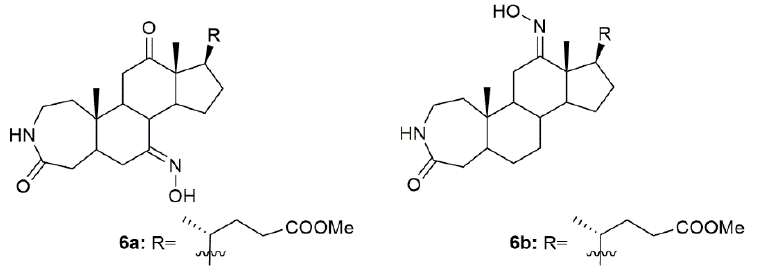
Figure 9. Steroidal bile acid oxime derivatives with antitumor activity in several types of cancer cells.